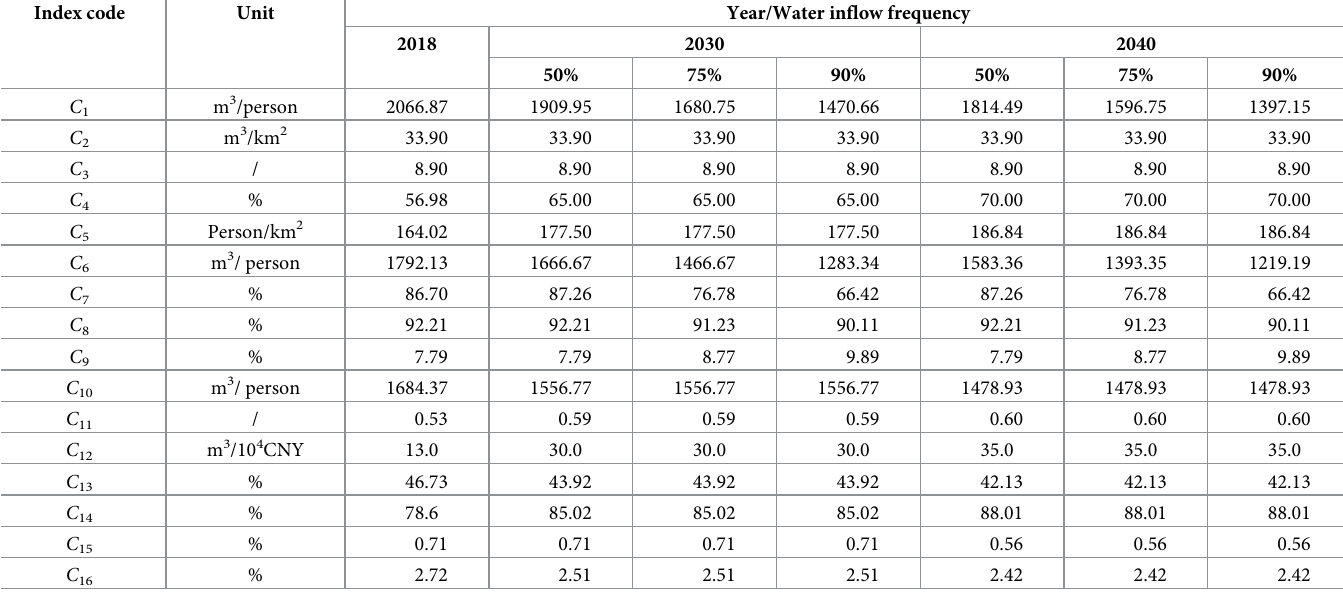
Table 5. Actual value in 2018 and forecast value of indicators in 2030 and 2040 with different inflow frequencies.